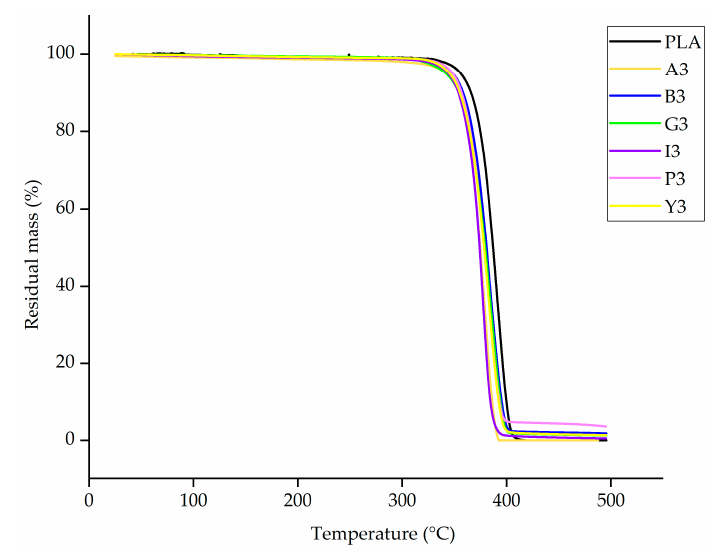
Figure 6. TGA thermogram of PLA and its composites containing 3% (w/w) of each additive, showing no significant difference between the degradation curves.